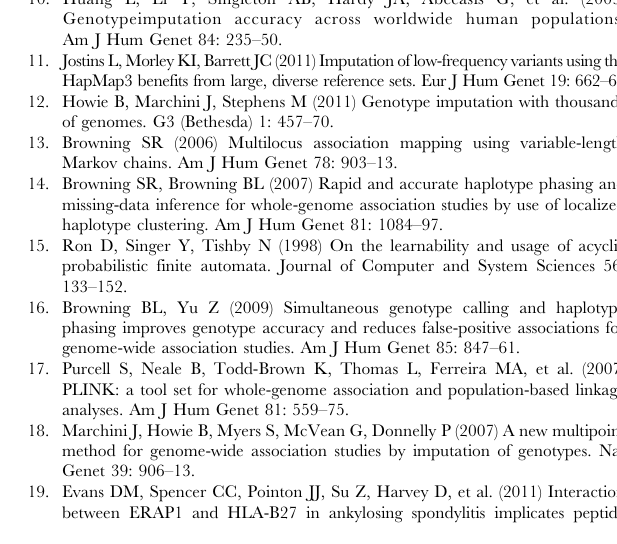
Table S4 HLA-DPB1 and DRB3-5. Allele-specific sensitivity, specificity, PPV and r 2 for the first experiment (HLA*IMP:02, GS { w HLARES_EU). ‘‘NValidation’’ specifies how often an allele appears in the validation data (according to classical typing results, which we treat as the truth in this experiment). ‘‘NImputation’’ specifies how often an allele appears in the imputations for the validation data. The following columns specify sensitivity, specificity, PPV and r2 for each allele. All numbers are based on ‘‘best-guess’’ called alleles. Table S5 HLA-DPB1 and DRB3-5. Allele-specific sensitivity, specificity, PPV and r 2 for the second experiment (HLA*IMP:02, GS&HLARES_EU 2/3 { w GS&HLARES_EU 1/3). ‘‘NVali- dation’’ specifies how often an allele appears in the validation data (according to classical typing results, which we treat as the truth in this experiment). ‘‘NImputation’’ specifies how often an allele appears in the imputations for the validation data. The following columns specify sensitivity, specificity, PPV and r2 for each allele. Mathematical and algorithmic characterization of the haplotype graph model of HLA*IMP:02, allowing for integrating over path uncertainty and